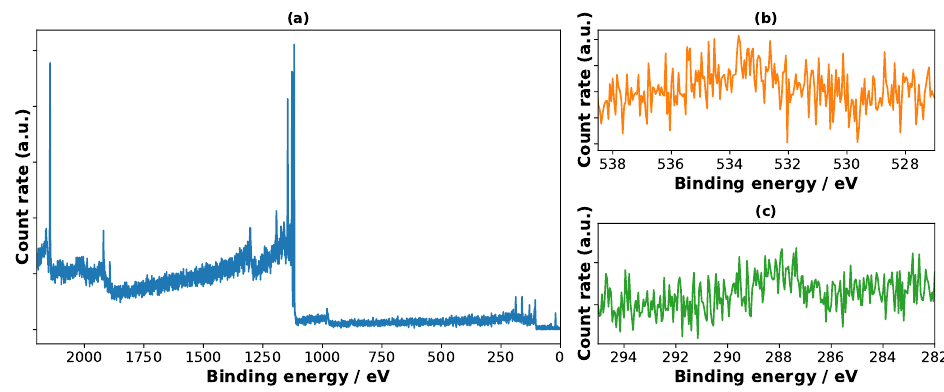
Figure 3: XPS of P-rich GaP(100) after a 58 kL water dose, measured at a take-off angle of 60 ◦ against normal emission. (a) Overview spectrum with Ag L α at 30 eV pass energy. The binding energy is referred to the Fermi level. (b) Detail spectrum around the O 1s emission with the same excitation, avoiding Ga Auger lines present for Al K α . (c) Detail spectrum around C 1s with Al K α